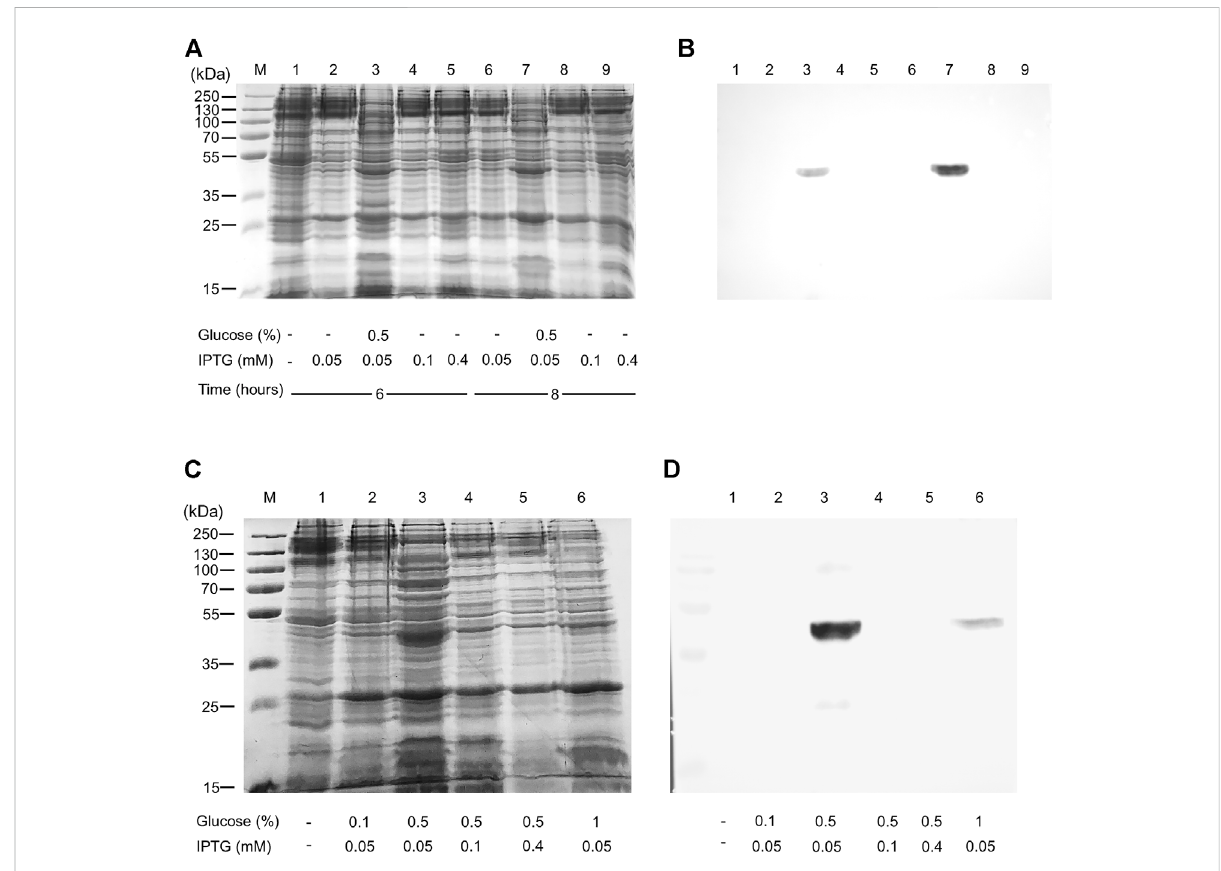
FIGURE 1 Human xCT expression in E. coli BL21. E. coli BL21 codon plus was transformed with hxCT-pH6EX3 construct and cultured in the absence or presence of 0.5% glucose. The effect of different IPTG concentrations at different times of induction was also tested. (A) SDS-PAGE of insoluble fractions from: 1, uninduced cell lysate; 2 – 9 induced cell lysates in different conditions: IPTG, glucose concentration and times of growth are indicated in the fi gure; M, page ruler prestained plus marker; (B) Western blotting using an anti-His antibody of the samples loaded as in (A) . (C) SDS-PAGEofinsolublefractionsafter 8 hofgrowth from:1,uninducedcelllysate; 2 – 6induced celllysatesindifferentconditions:IPTG andglucose concentrationsareindicatedinthe fi gure;M:pagerulerprestainedplusmarker. (D) WesternblottingusingantiHisantibodyofthesamplesloadedas in (C)